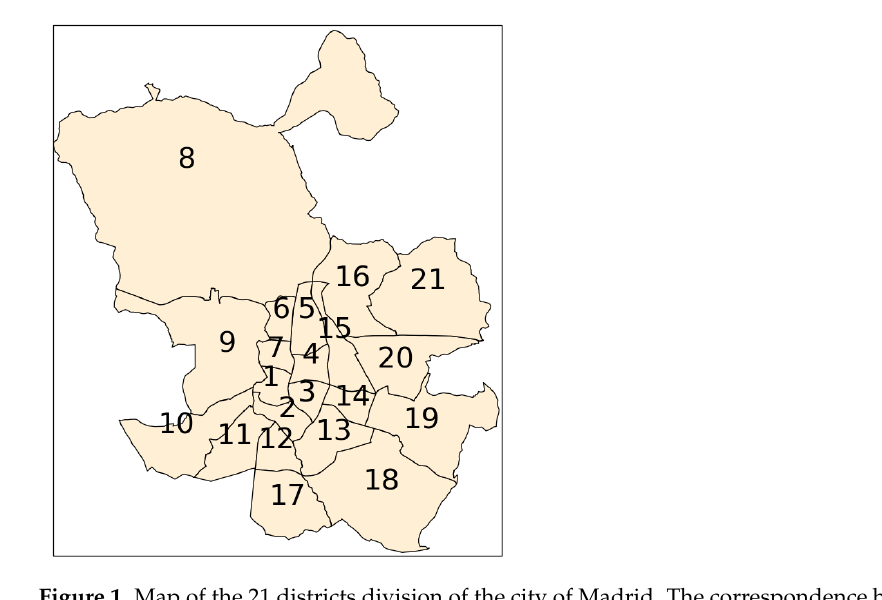
Figure 1. Map of the 21 districts* division of the city of Madrid. * The correspondence between the Id number and the name of the district can be found in Table 1. Table 1. Total population, elderly population, percentage of elderly population over total popula- tion, percentage of elderly women over elderly population, net migration, per district, Madrid. * Migration growth in 2020. Rates per 1000 inhabitants. Source: Madrid City Council, 2020 and 2022.